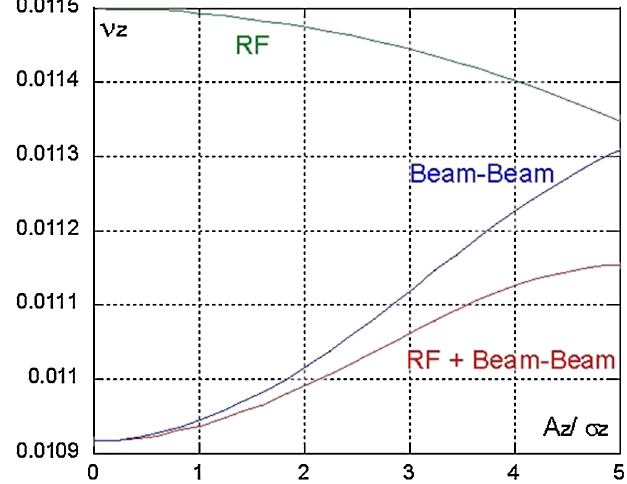
FIG. 9. Synchrotron tune dependence on normalized ampli- tude of synchrotron oscillations (blue curve—tune dependence created by beam-beam collisions alone; green—rf nonlinearity alone; red—both